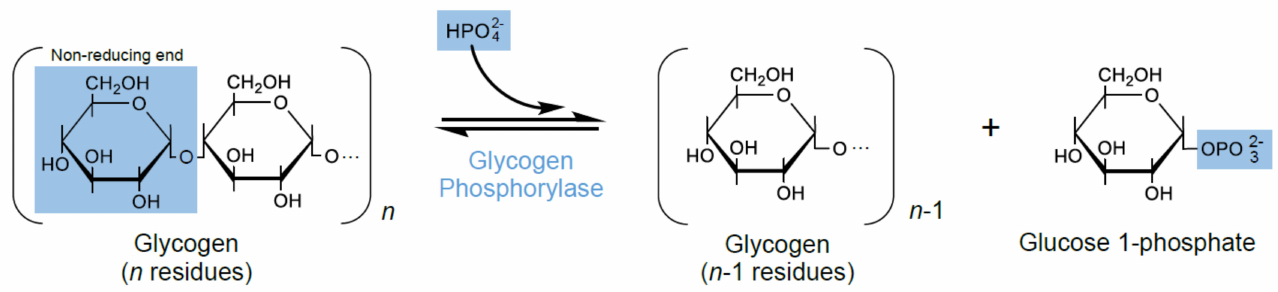
Figure 1. GP reversible reaction, catalyzing the degradation of the non-reducing ends of glycogen into glucose 1-phosphate. HPO 42 − , monohydrogen phosphate anion; OPO 32 − , phosphate group.